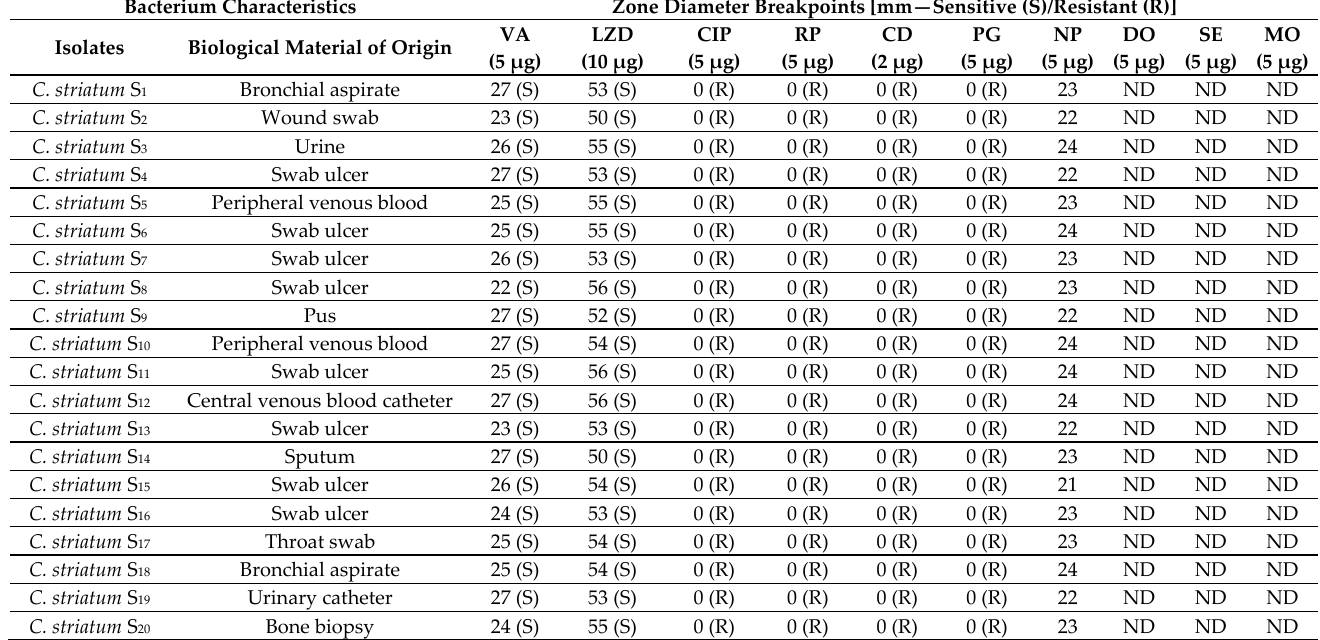
Table 1. Isolation sites of isolates the and inhibition zone of vancomycin (VA, 5 µg), linezolid (LDZ, 10 µg), ciprofloxacin (CIP, 5 µg), rifampicin (RP, 5 µg), clindamycin (CD, 2 µg),